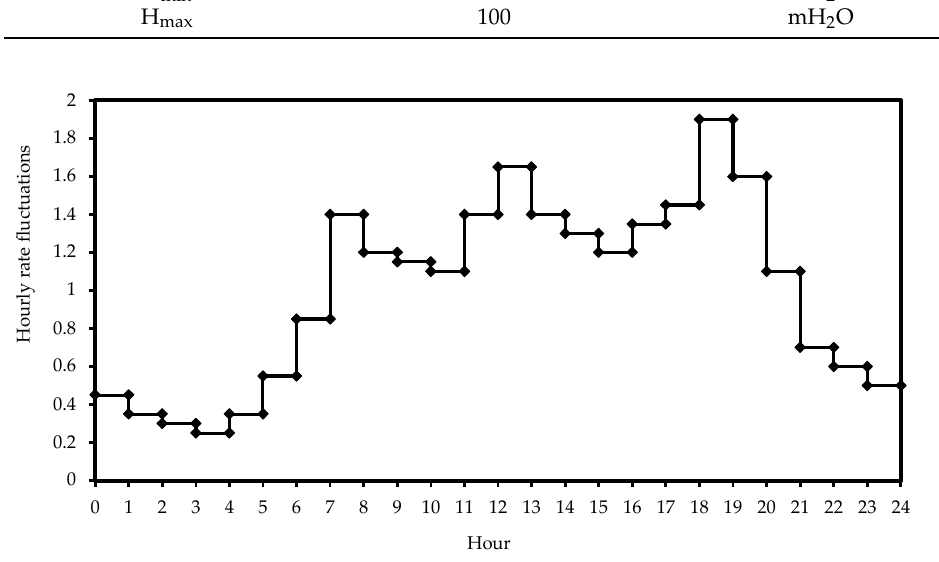
Figure 4. The consumption coefficients. Table 4. Basic information on the energy sector